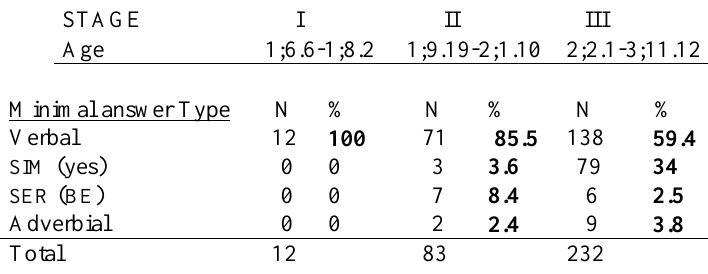
Table II. Stages in the acquisition of minimal answers in Inês’